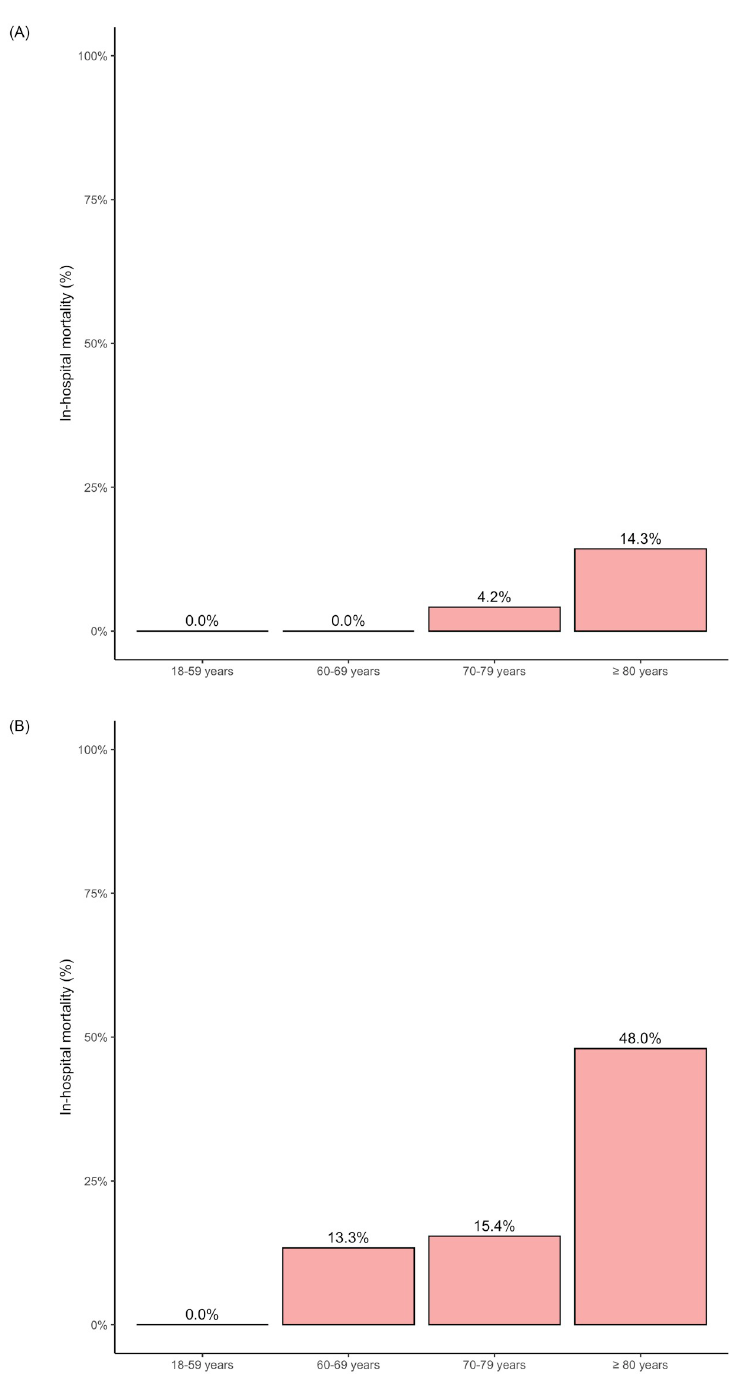
Fig 1. A. In-hospital mortality by age category in non-ventilated COVID-19 patients. B. In-hospital mortality by age category in ventilated COVID-19 patients.